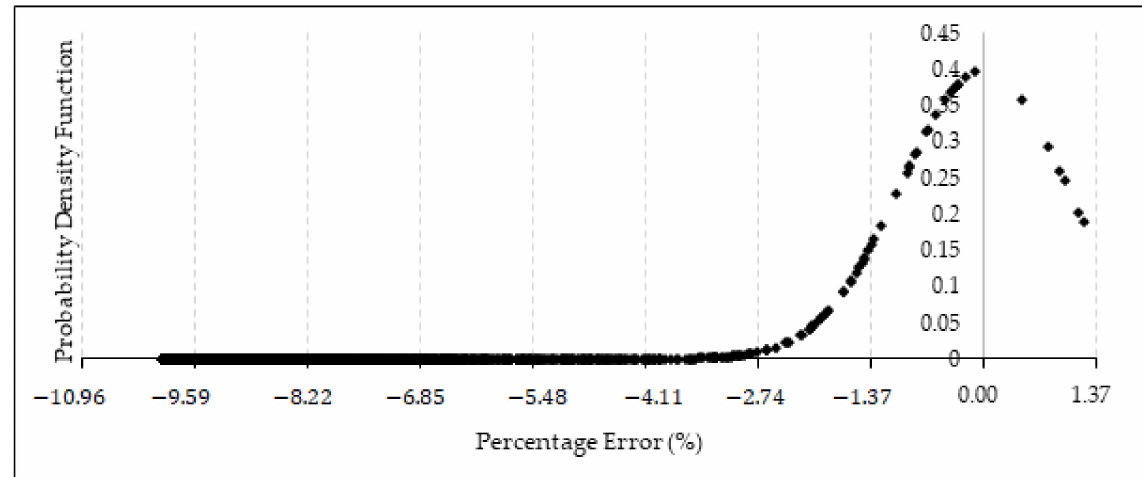
Figure 10. Probability distribution of the percentage error obtained using the new empirical failure pressure assessment method and FEM based on the parameters of the ANN training data.